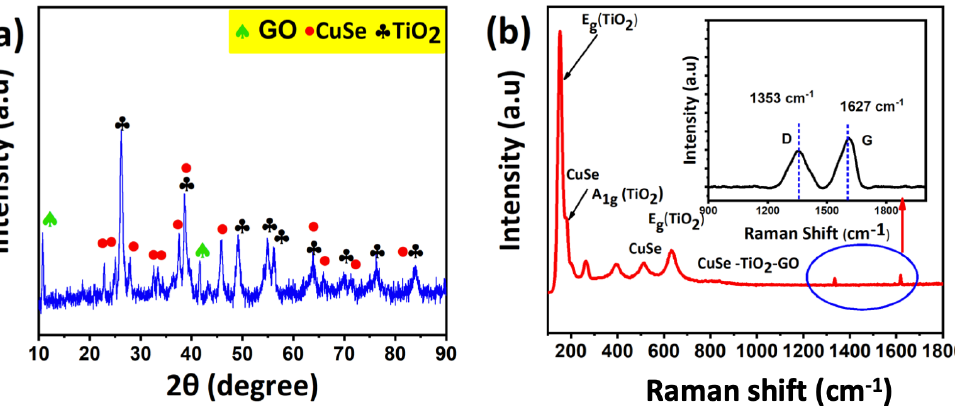
Figure 4. ( a ) X-ray diffraction pattern and ( b ) Raman analysis. The inset is the magnified view of the D and G bands of GO in the CuSe-TiO 2 -GO